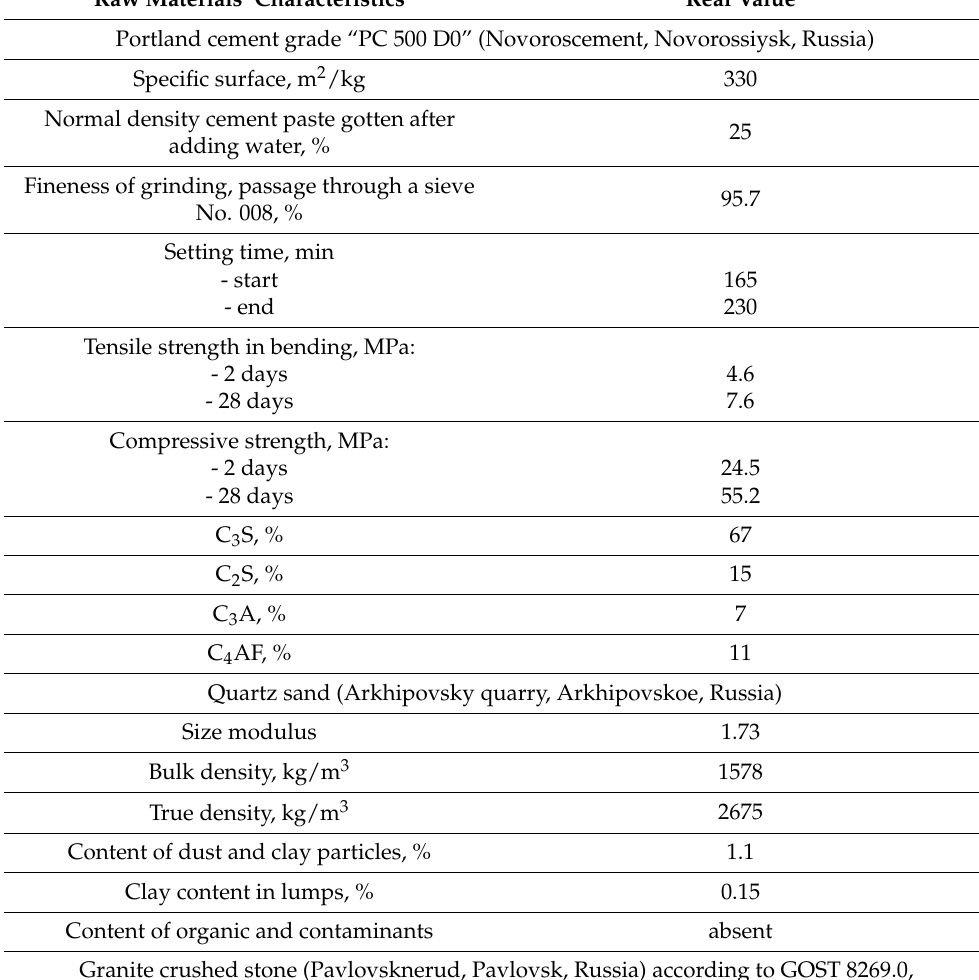
Table 1. Characteristics of raw